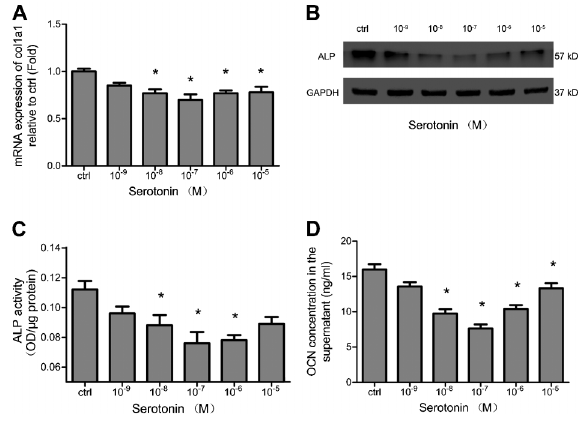
Figure 2. Serotonin affected the differentiation of primary osteoblasts. A , Real-time RT-PCR was used to evaluate the effect of different concentrations of serotonin on expression of col1a1 mRNA at day 5. Expression of col1a1 mRNA was decreased with low concentrations of serotonin, and this effect was alleviated at high concentrations. B , Expression pattern of ALP protein revealed by Western blot analysis in the presence of serotonin at day 10. C , Action of serotonin at different doses on ALP enzyme activity at day 10. D , ELISA analysis showed that at day 15, OCN content in the cultured supernatant was reduced in serotonin groups compared with the control group. Data are reported as means±SE. *P , 0.05 vs control (ctrl) group (Dunnett